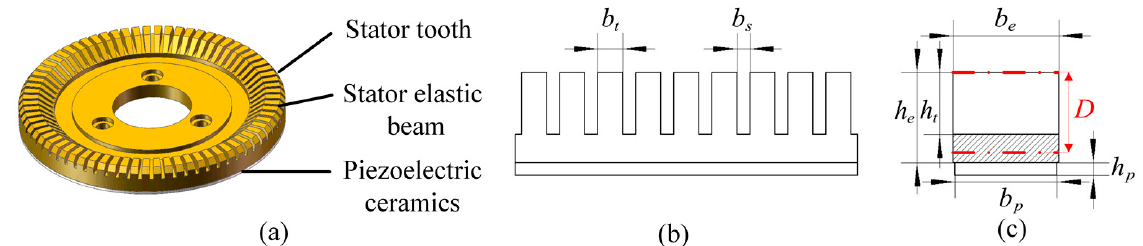
Figure 1. Schematic diagram of the stator structure of the ultrasonic motor: ( a ) stator structure with teeth; ( b ) expanded equivalent model diagram of the piezoelectric composite stator; and ( c ) tooth groove section diagram.